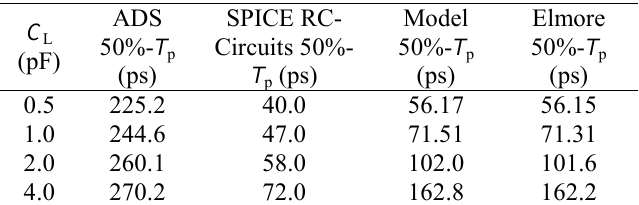
Table 5: Comparison of the 50%-propagation delay computed with SPICE and calculated with the proposed model the Elmore one versus load C L for the case 1.